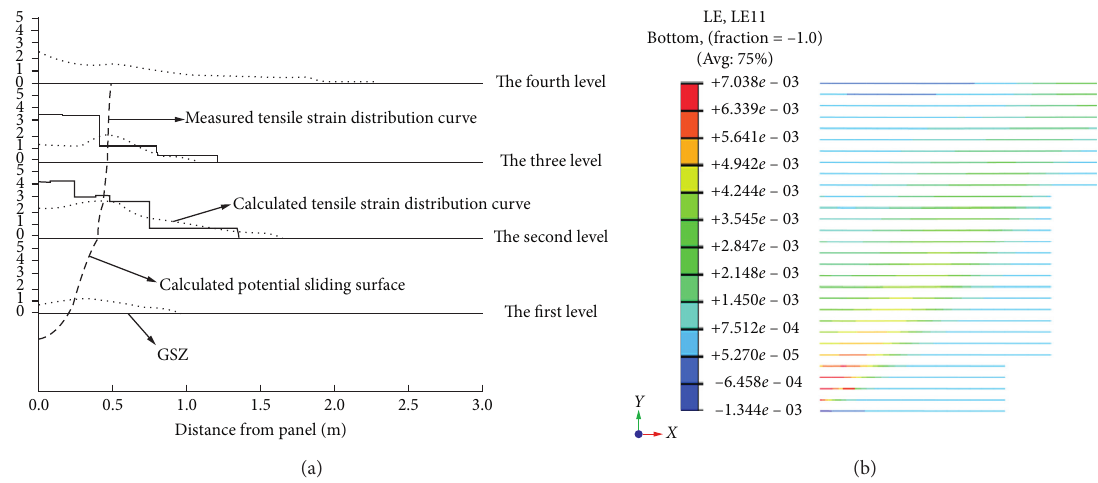
Figure 5: Calculated tensile strain distribution of the reinforced layer (in this study, there are 30 layers of reinforced strip). (a) Assumed fracture surface. (b) The trend of tensile strain distribution of steel bars.